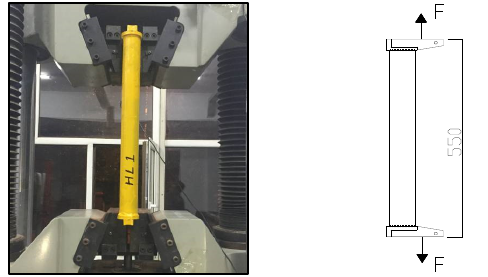
Figure 2. Experimental device of socket tension and loading diagram.